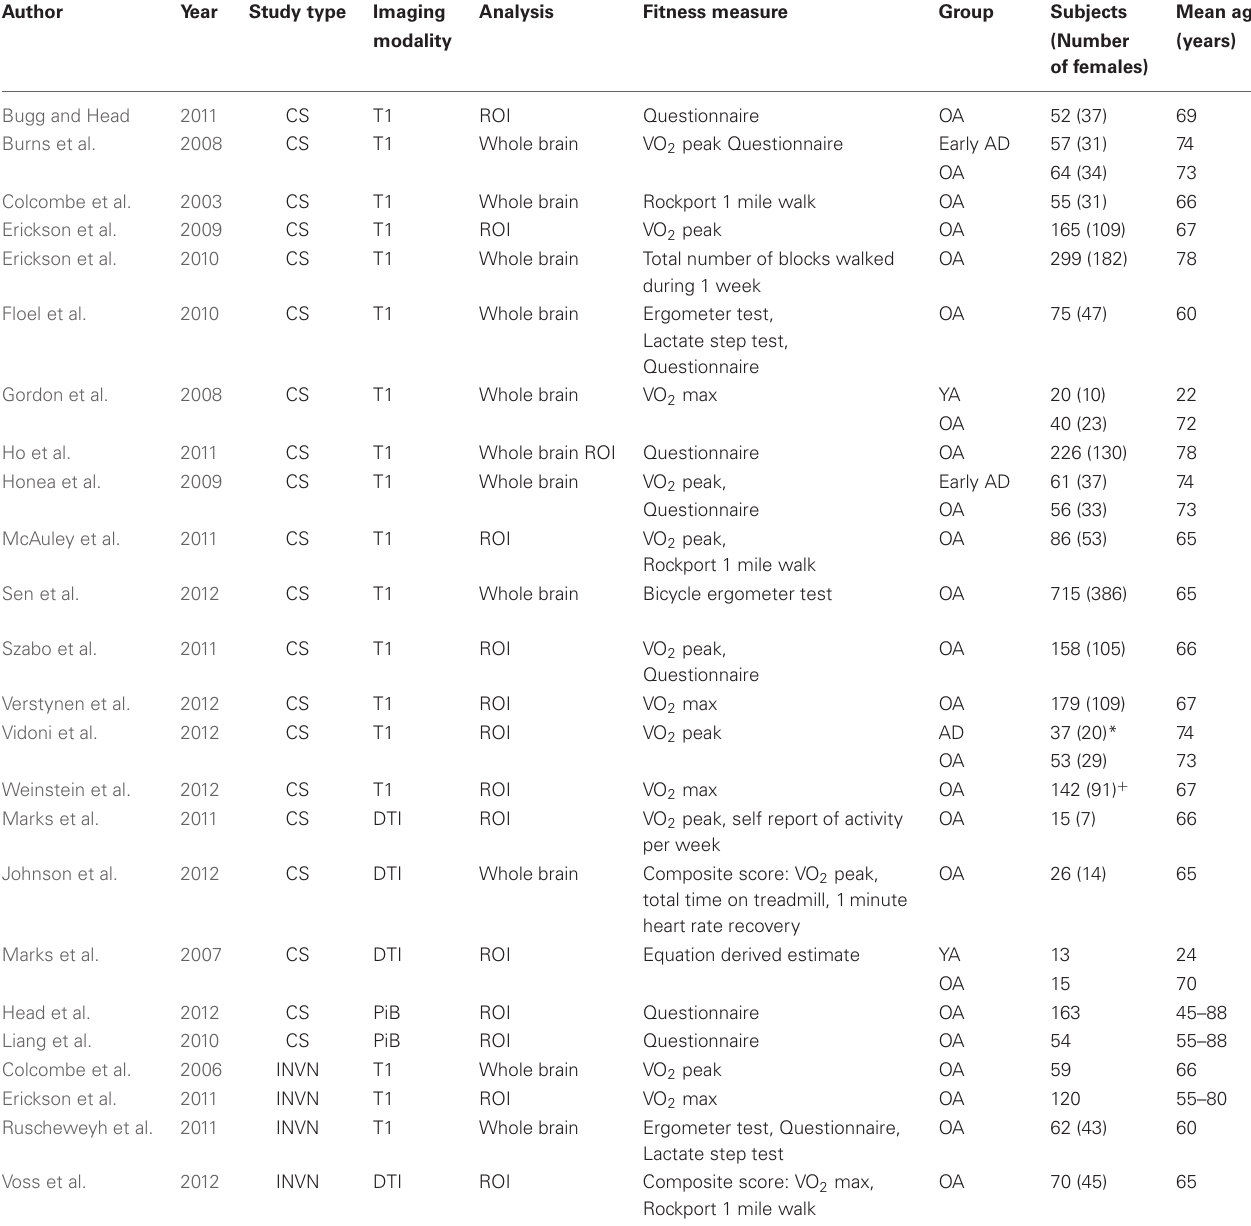
Table 1 | Cross-sectional (CS) and exercise intervention (INVN) studies examining the relationship between cardiorespiratory fitness and brain